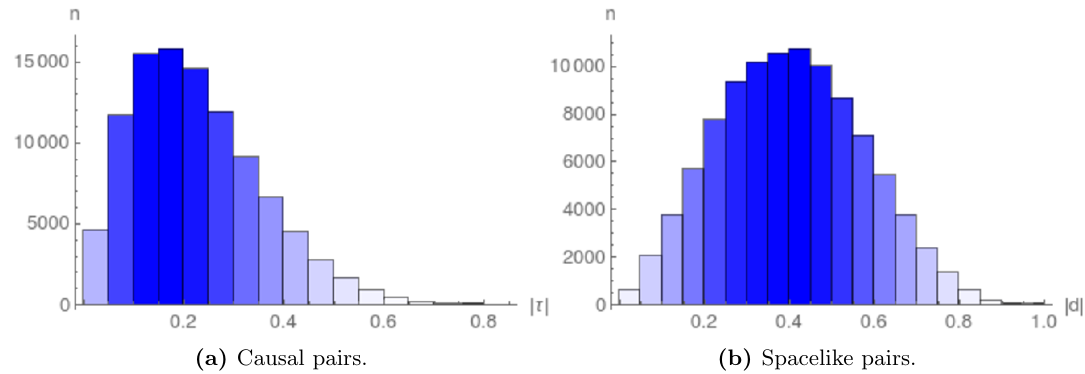
Figure 9. Distribution of the number of causal and spacelike pairs n with magnitude of the geodesic distance for N = 30 k , in the 4d causal